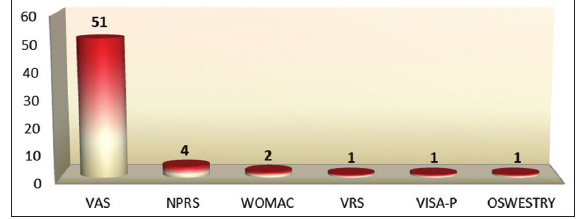
FIGURE 4. Distribution of articles per pain assessment